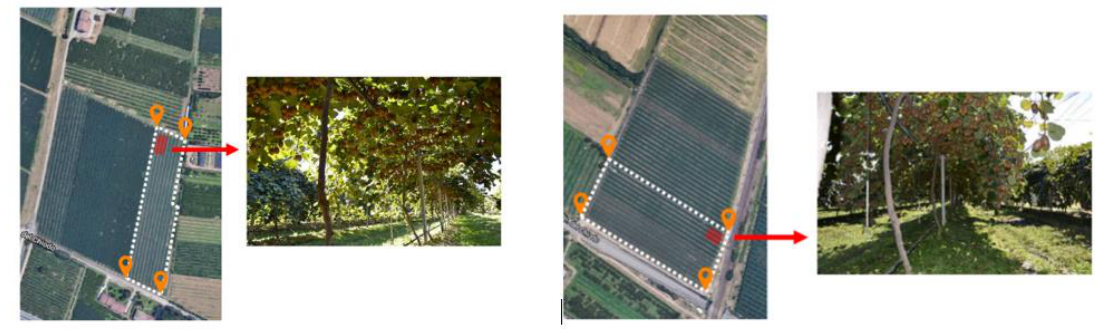
Figure 13. Experimental orchards depiction on Google Maps as well as on-site. ( Left ): orchard 1. ( Right ): orchard 2.